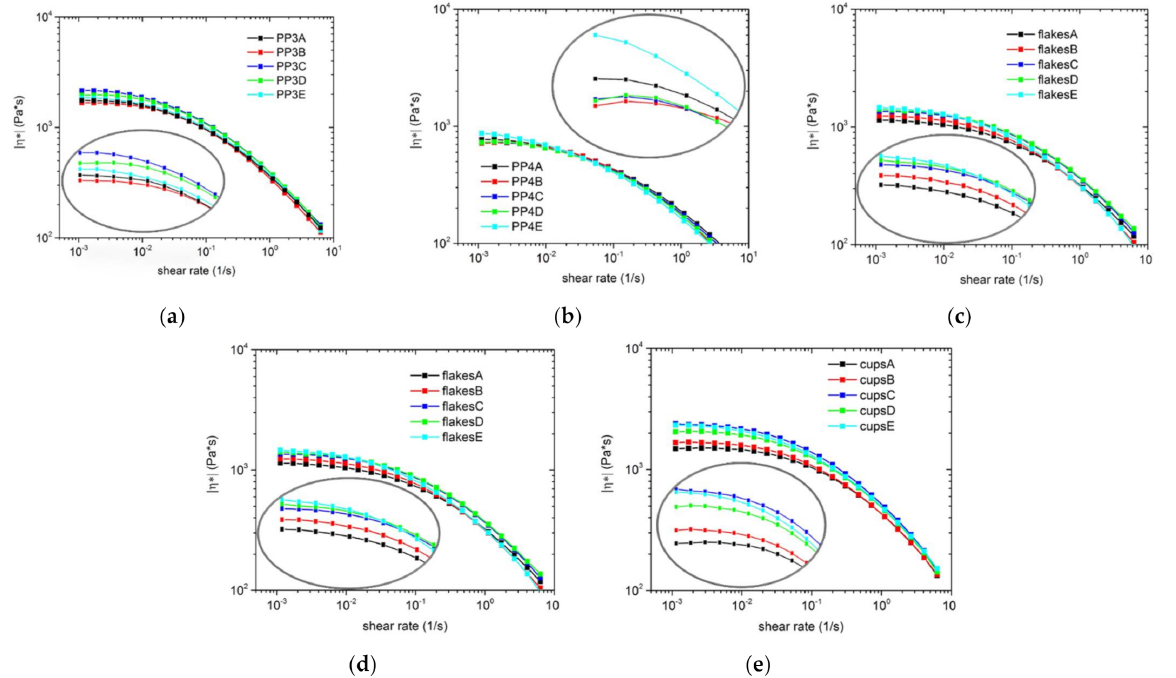
Figure 3. Complex viscosity of all samples (polypropylenes PP3 ( a ) and PP4 ( b ), flakes ( c ), cups ( d ), bucket ( e )) and their blends; measured at 230 ◦